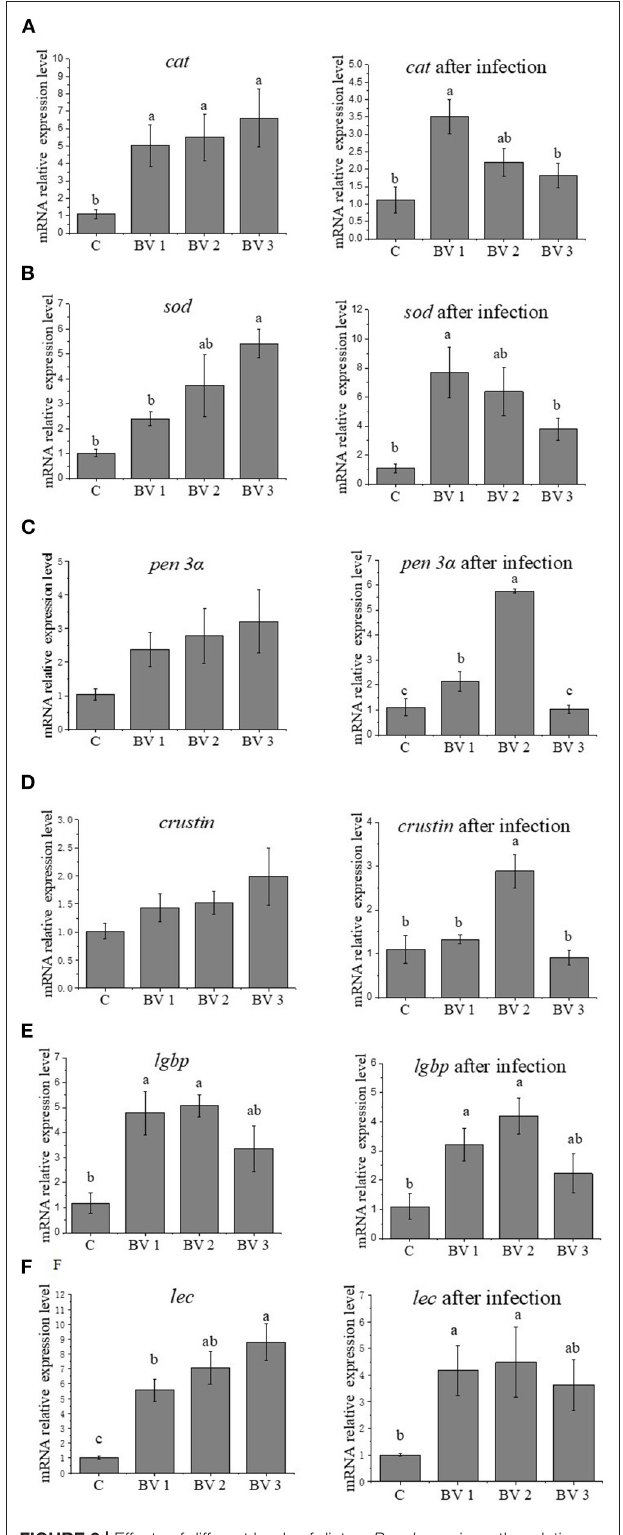
FIGURE 2 | Effects of different levels of dietary B. velezensis on the relative expression of cat (A) , sod (B) , pen 3 α (C) , crustin (D) , lgbp (E) , and lec (F) in hepatopancreas. Error bars with different letters (a, b, c) represent statistically significant differences based on the LSD method ( P < 0.05, one-way ANOVA). The results were shown as mean ± SE ( N =